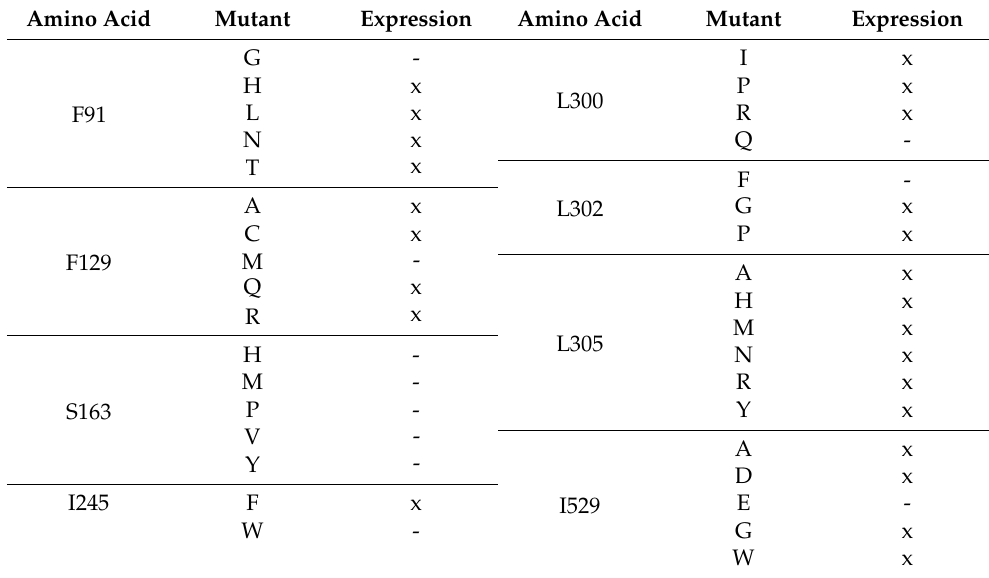
Table 1. PCI_Lip mutants with higher selectivity towards short- and medium-chain fatty acids predicted in silico. x = successful expression, - = expression was not possible as no protein band was visible in the SDS-PAGE after